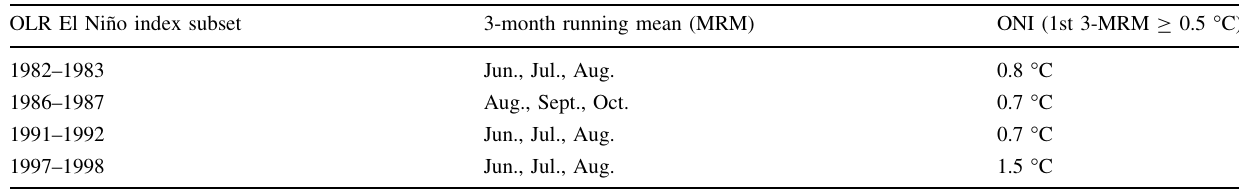
Table 2 Outgoing longwave radiation (OLR) El Nin˜o Index and Oceanic Nin˜o Index (ONI) 3-month running mean (3-MRM) anomalous sea surface temperature (SST) warming in Nin˜o 3.4. Sources : Chiodi and Harrison (2016), NOAA (2019b) OLR El Nin˜o index subset 3-month running mean